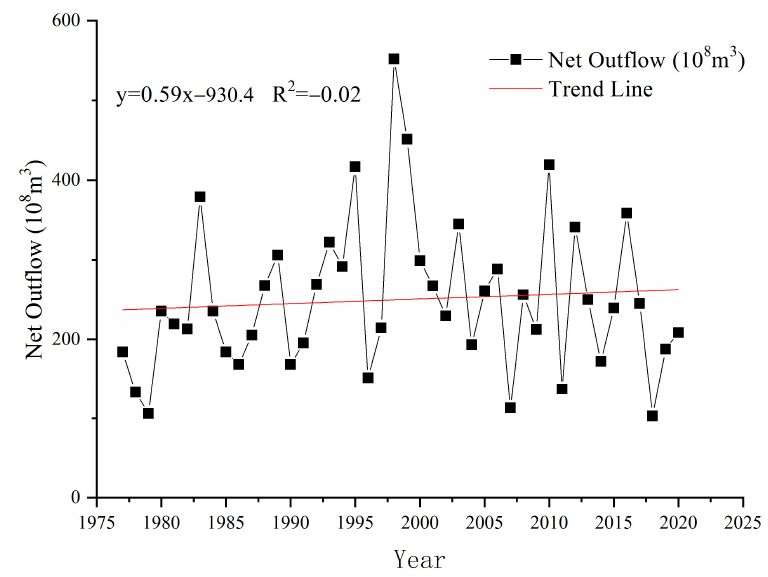
Figure 6. Characteristics of net outflow in the Poyang Lake during 1977–2020.